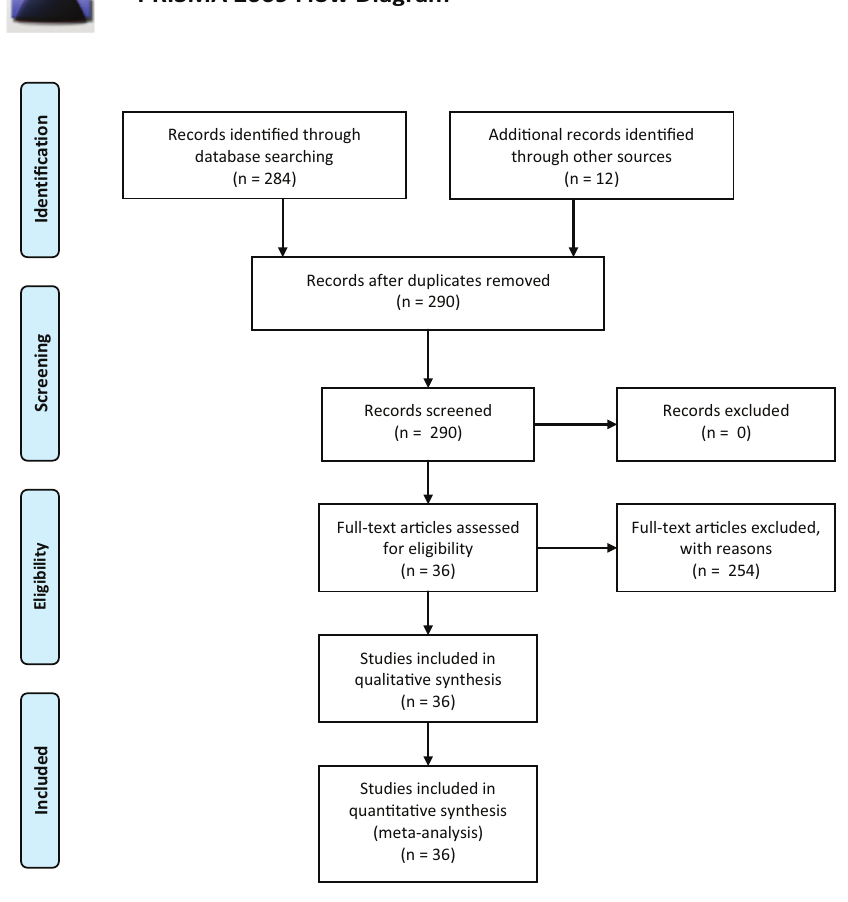
Figure 1. Approach to systematic review of studies on vagus nerve stimulation to treat inflammation. Based on template provided by Preferred Reporting Items for